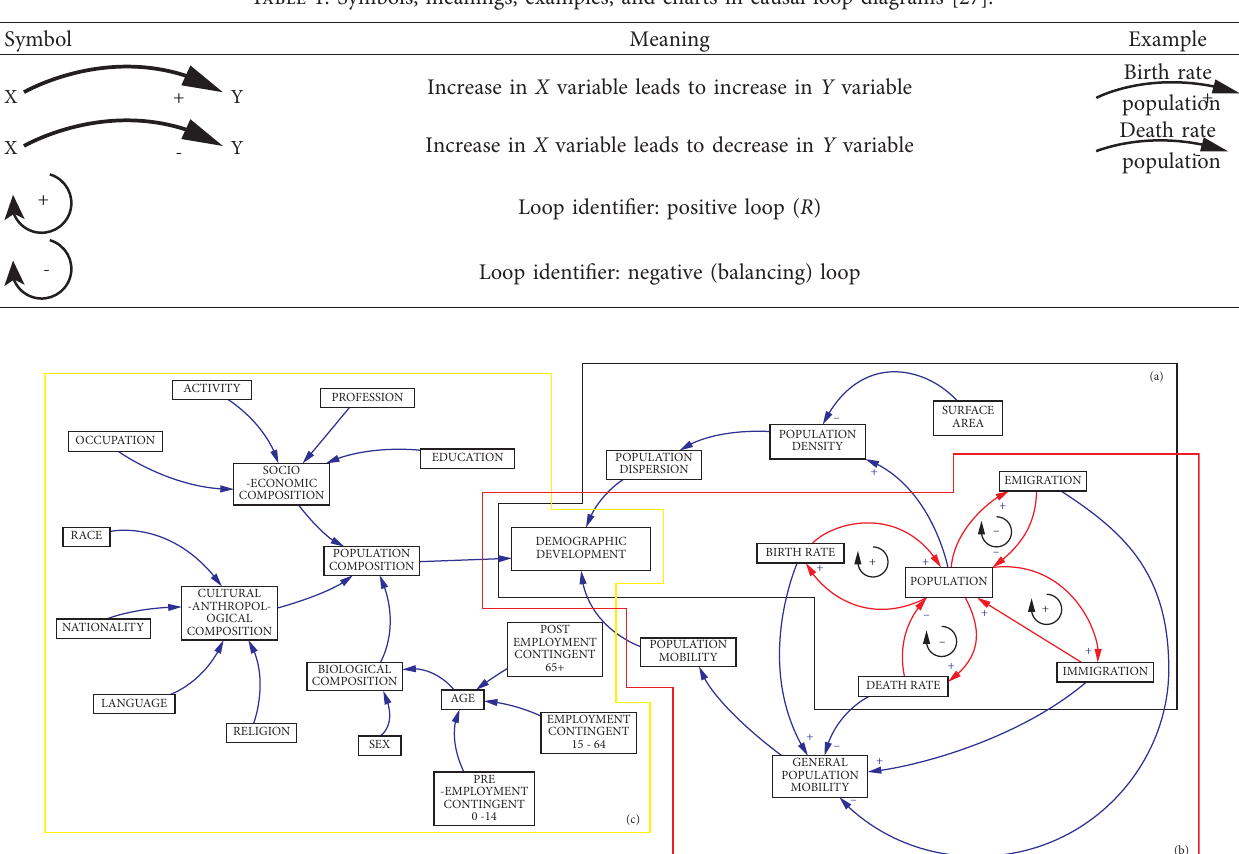
Figure 1: Structure of feedback loops (causal loop diagram) in the system of demographic developmental criteria.